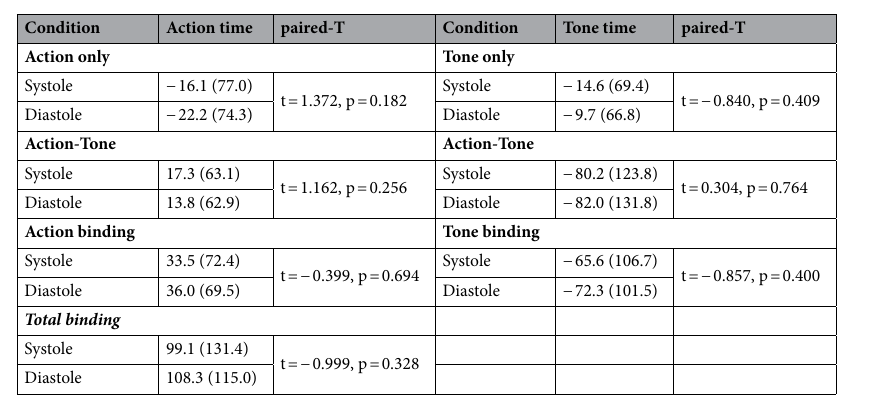
Table 2. Effects of heartbeats on agency regardless of